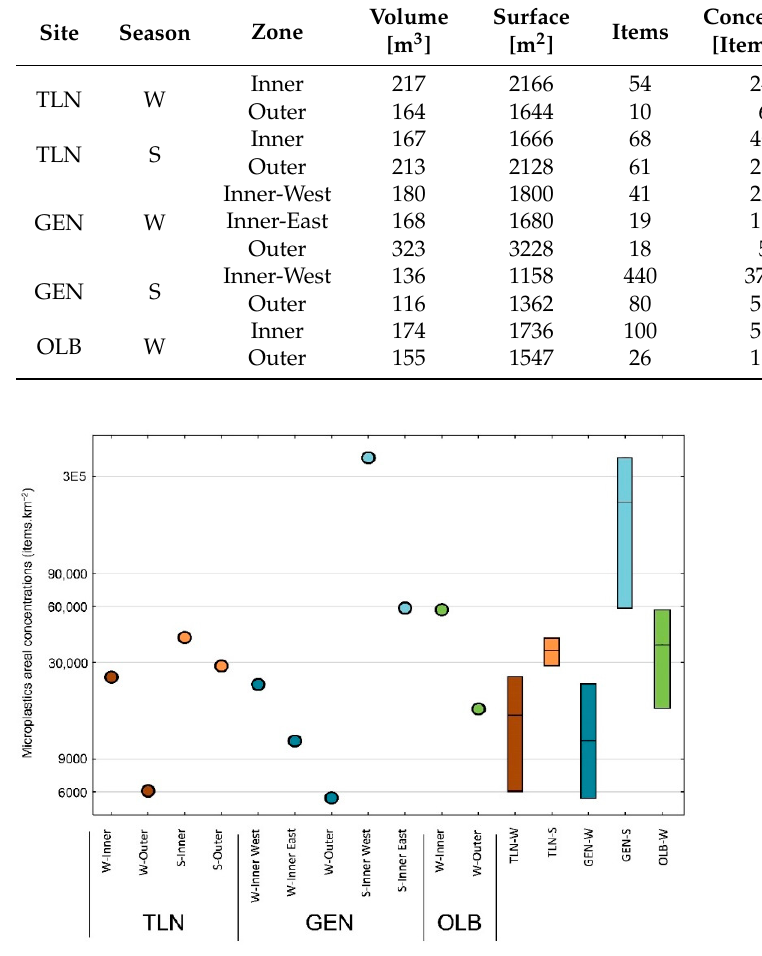
Figure 2. Areal concentrations of microplastics at different sites (TLN: Toulon, in orange, GEN: Genova, in blue and OLB: Olbia, in green), seasons (W: winter, in dark color and S: summer, in light color) and zones (Inner and Outer). The box-plots at right represent the interquartile range for each site and season with the median represented by an horizontal